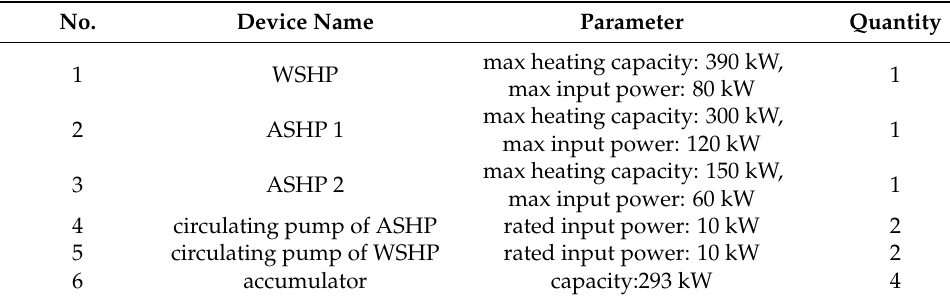
Figure 4. Heat load during heating period. Table 2. Main equipment and their parameters.